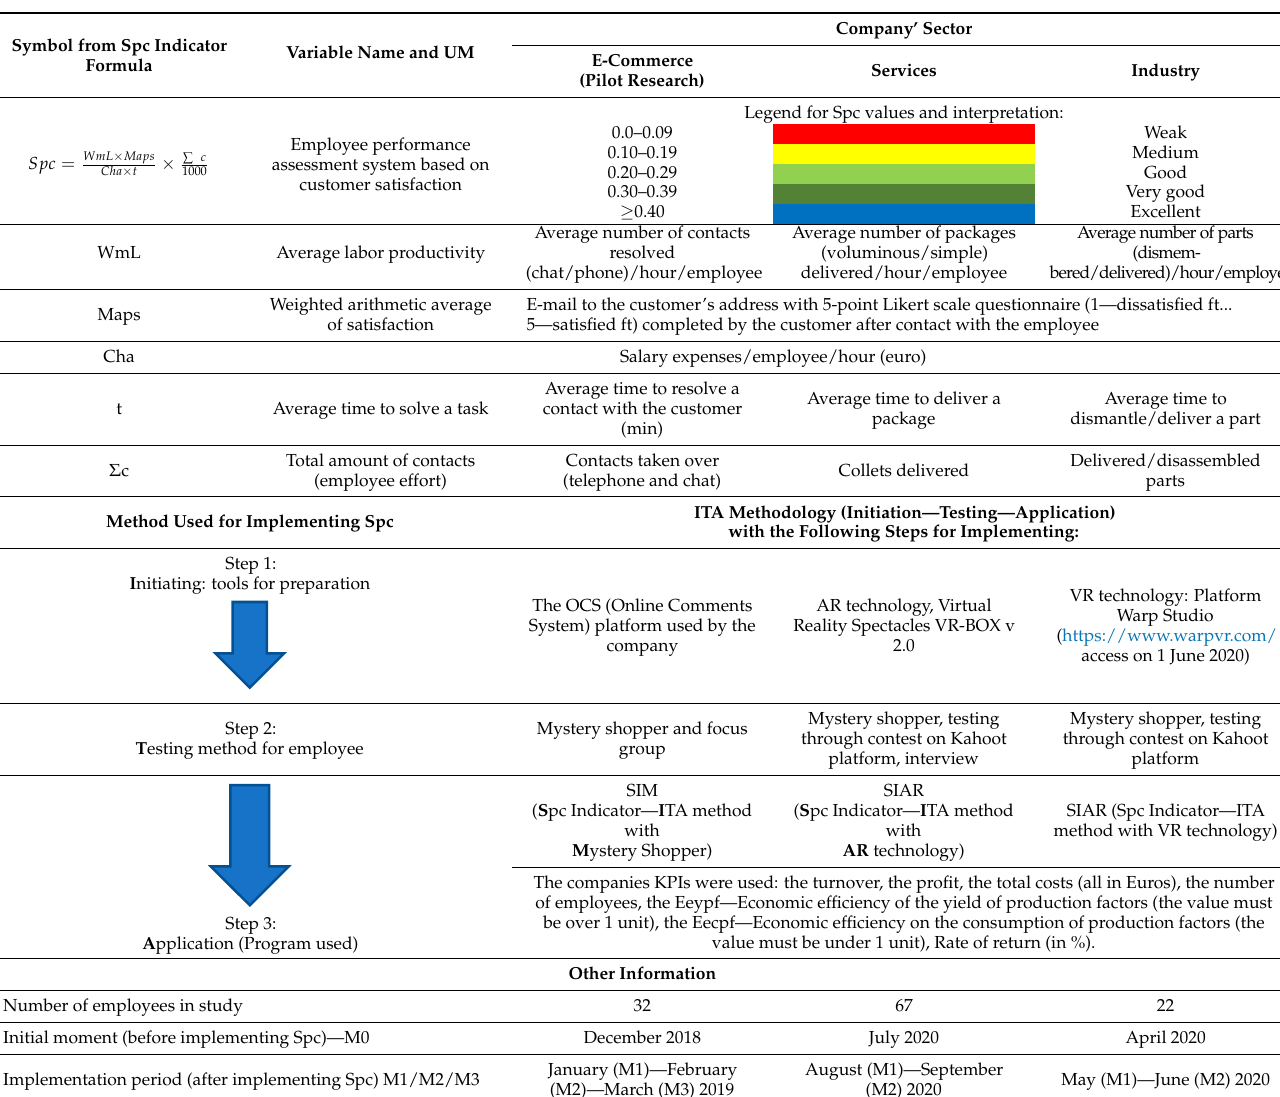
Table 2. Comparative table for describing Spc indicator variables and implementation methodology.